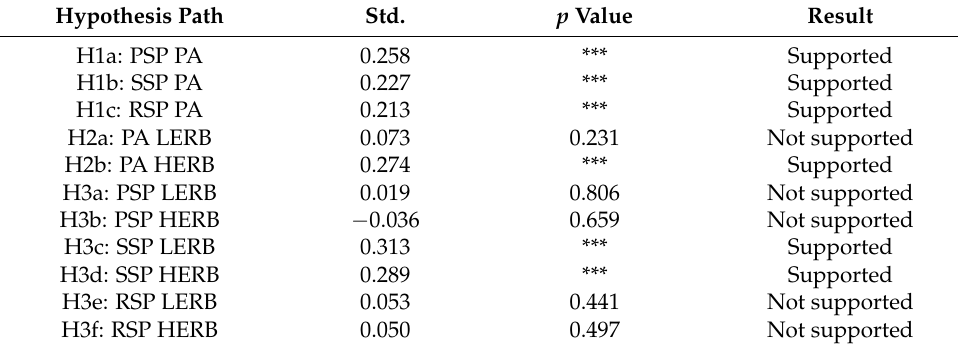
Table 6. Path coefficients and hypothesis results.